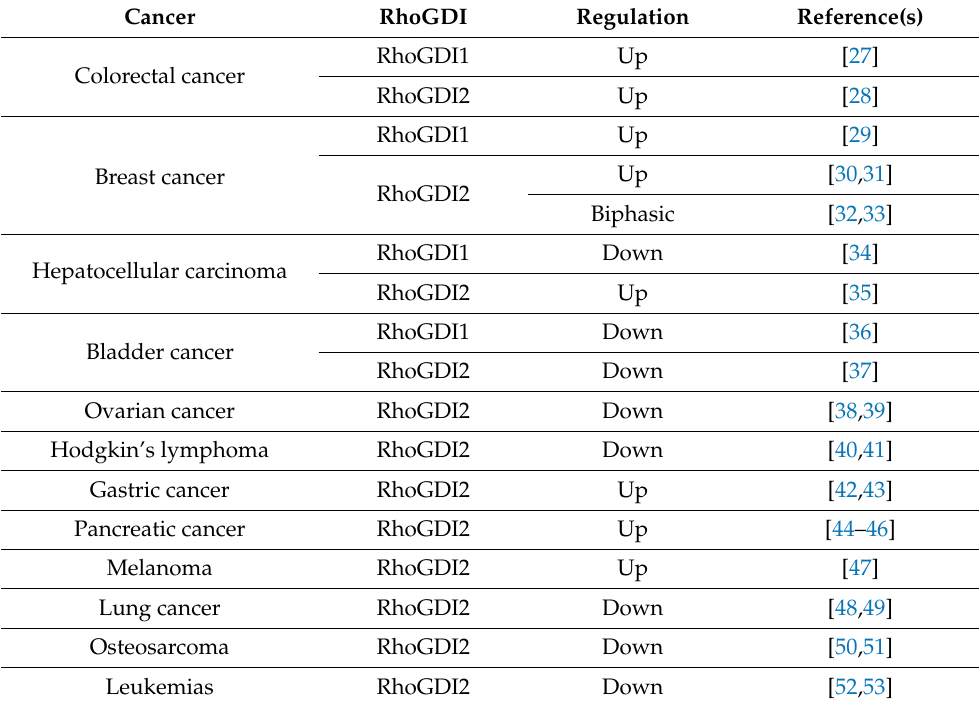
Table 1. Expression of RhoGDI1 and RhoGDI2 in human cancers. Biphasic, up and then